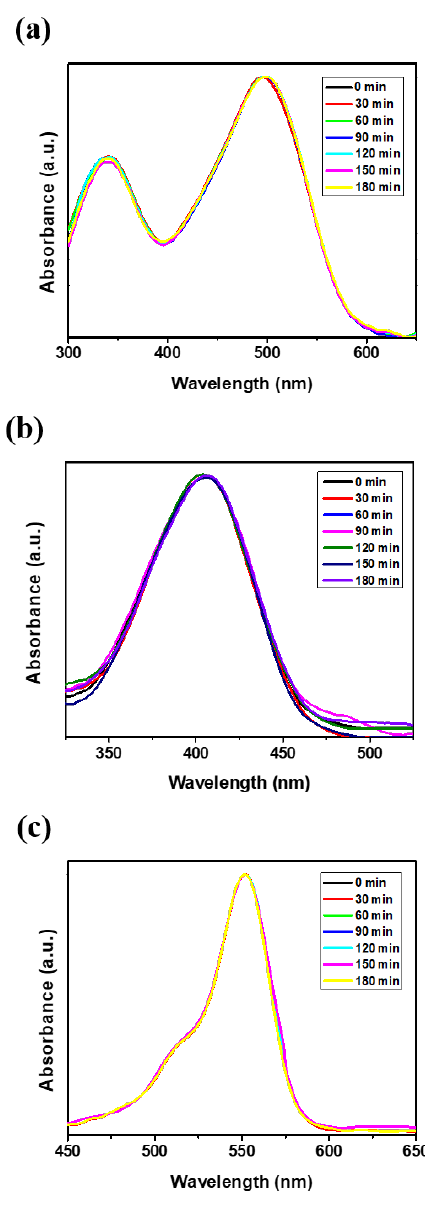
Figure 7. UV-vis absorption spectra of ( a ) the Congo Red (CR) aqueous solution (10 mg / L), ( b ) the basic yellow (BY) aqueous solution (50 mg / L), ( c ) the Rh B aqueous solution (10 mg / L).